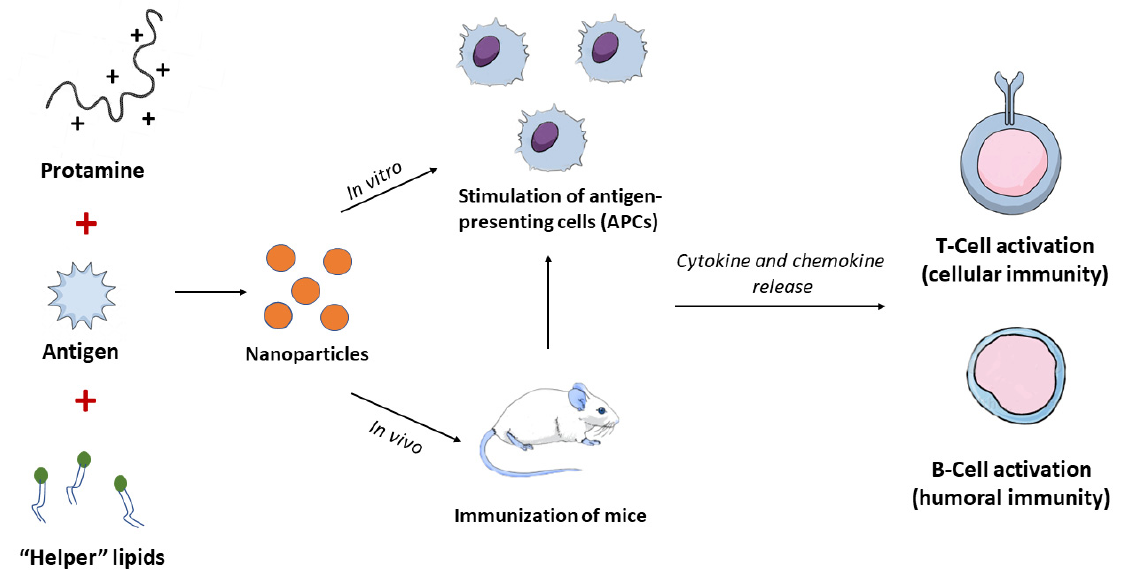
Figure 8. Mechanism of action of protamine vaccines. When protamine is complexed with antigens, it forms NPs that can be used as delivery systems for the antigens. Whether applied in vitro or in vivo, protamine vaccines stimulate the antigen-presenting cells (APCs), such as dendritic cells, which in turn start releasing cytokines and chemokines. These signaling molecules further activate the humoral immunity (B-cells which produce antibodies) and cellular immunity (T-helper cells and cytotoxic T-cells).